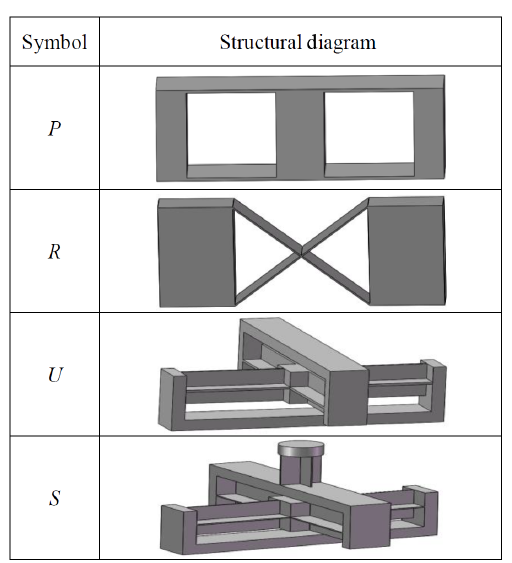
Table 8. Some typical flexure hinges.